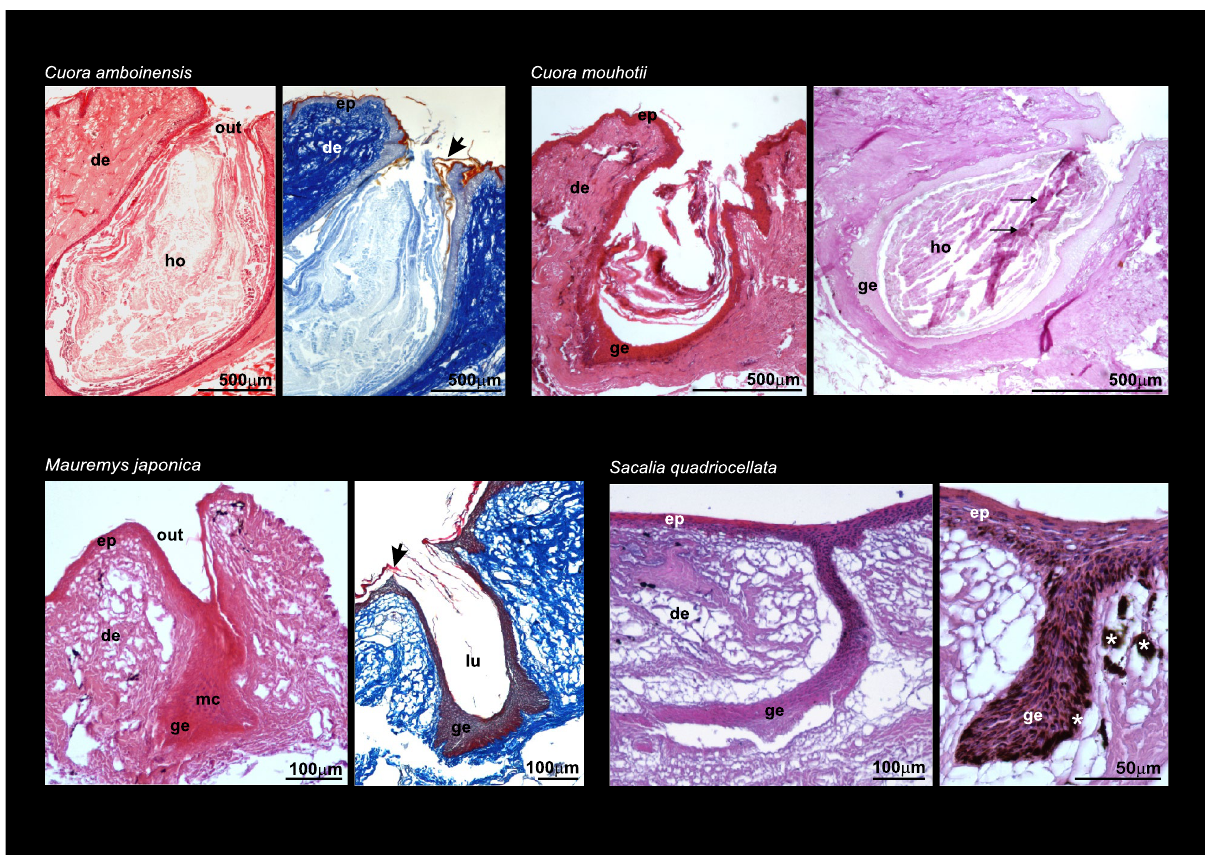
Figure 3. Histological plate showing mental gland structure in males of four species of geoemydid turtles. Staining techniques: Cuora amboinensis and Mauremys japonica ; Haematoxylin Eosin (left) and Mallory’s Trichrome (right). Cuora mouhotii ; Haematoxylin Eosin (left) and Periodic Acid-Schiff stain (right). Sacalia quadriocellata , Haematoxylin Eosin. Arrows point to keratinized layer (red colored) in Cuora amboinensis and Mauremys japonica . Arrows in Cuora mouhotii point to holocrine secretion reacting positively to PAS. In Sacalia quadriocellata , asterisks point to melanocytes. Abbreviations: de, dermis; ep, epidermis; ge, glandular epithelium; ho, holocrine secretion; lu, lumen; mc, mature cell; out, outlet of the